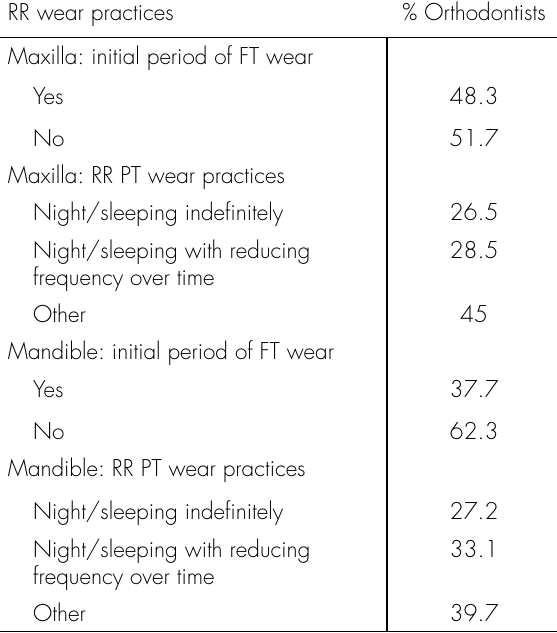
Table III. Removable retainer wear practices by orthodontists.